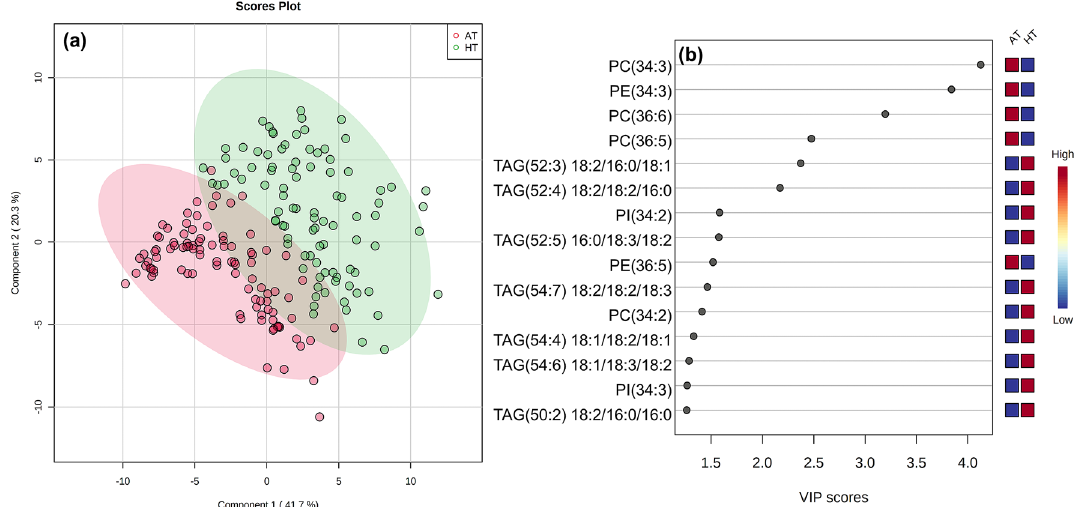
Figure 6. Partial least squares-discriminant analysis (PLS-DA) scores plot ( a ) demonstrating the differentiation of the two treatments: ambient temperature (AT, 31/22 °C for 2018 and 28/22 °C for 2019; average day/night temperatures during the 17-days and 18-days treatment periods in 2018 and 2019, respectively) and high temperature (HT, 41/27 °C for 2018 and 38/26 °C for 2019) and PLS-DA variable importance in projection (VIP) scores ( b ) that identified the top 15 lipid species that differentiated the treatments. A total of 89 lipid species were analyzed under the two treatments. Data from 2 years (2018 and 2019) were pooled together for analysis. PC, phosphatidylcholine; PE, phosphatidylethanolamine; PI, phosphatidylinositol; TAG, triacylglycerol. Lipid molecular species are identified as total acyl carbons: total double bonds. Acyl-chain composition is included after each TAG lipid species but does not indicate sn